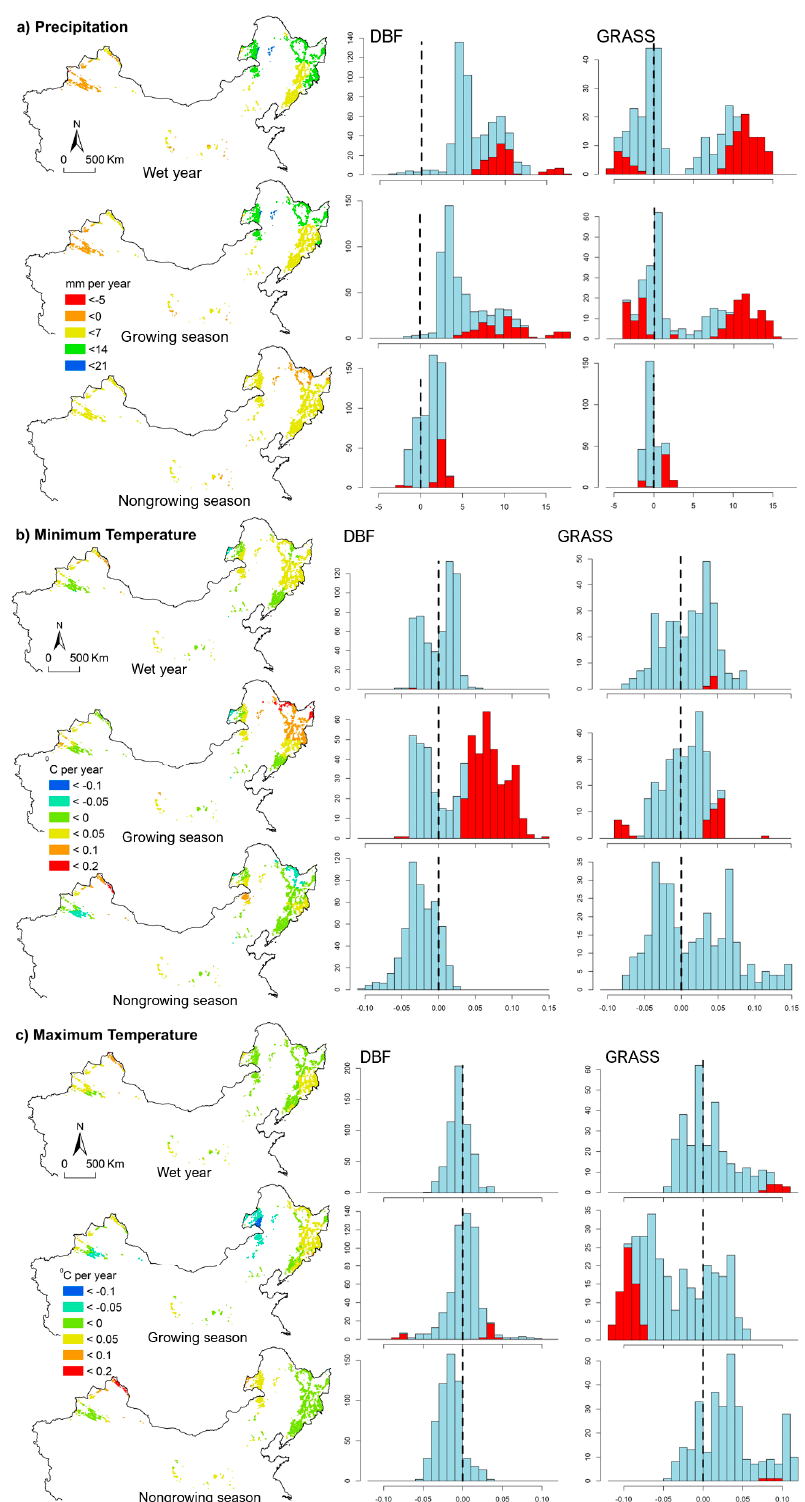
Figure 4. Trends of total precipitation ( a ), average minimum temperature ( b ), and average maximum temperature ( c ) during wet year (prior October to September), growing season (May to September), and nongrowing season (prior October to April) in 2001–2015 for the grassland (GRASS) and deciduous-broadleaved forest (DBF) patches. Right columns are histograms, and red bars on the left side of the dashed line indicate those trends significantly lower than 0 while those on the right side of the dashed line indicate those trends significantly greater than 0 ( p -value < 0.05, one-tail test).